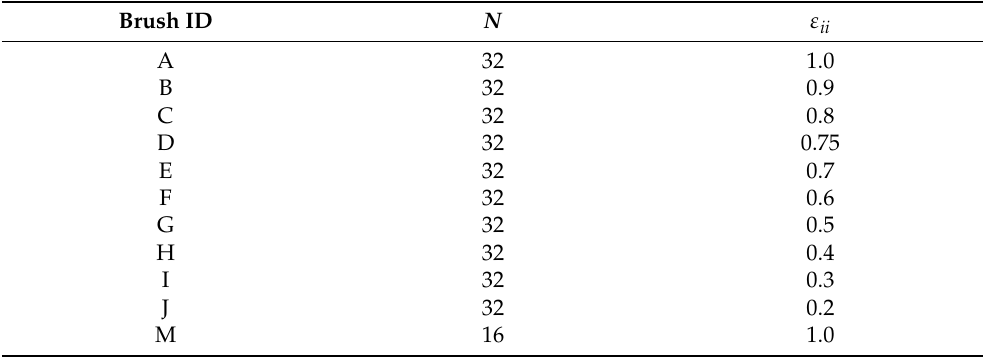
Table 1. Brush system classification. N is the number of monomers per chain, and ε ii is the LJ interaction strength between monomers in the